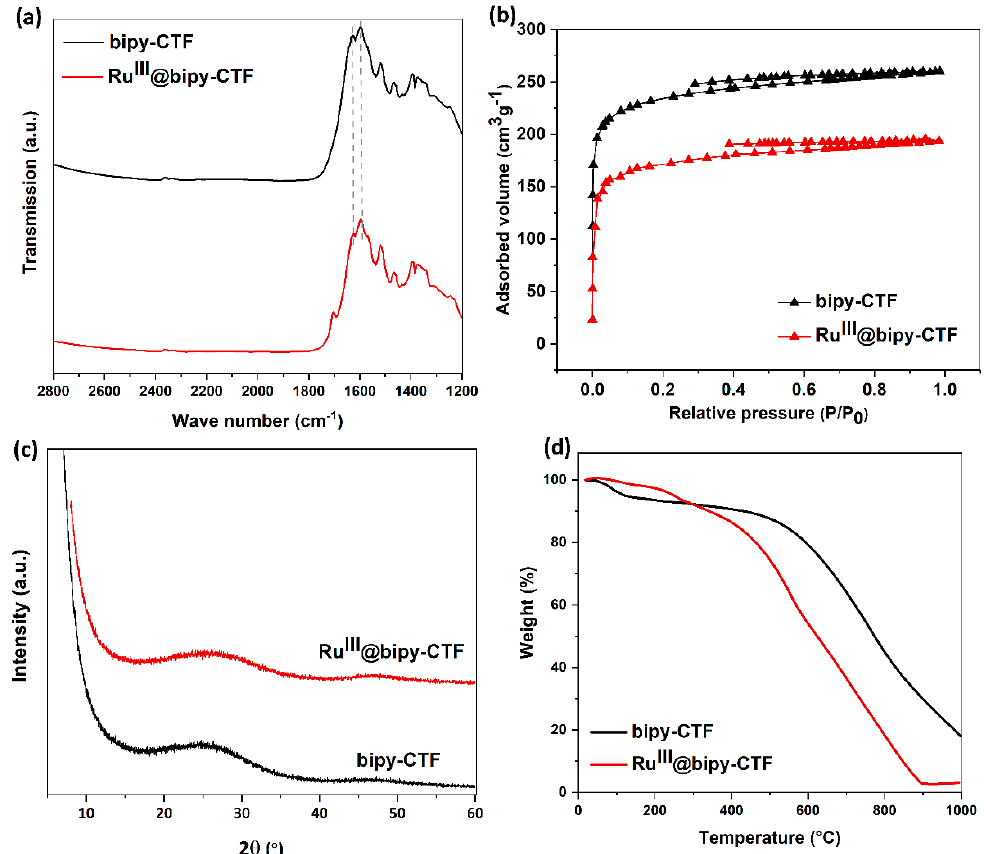
Figure 2. Structural characterization of bipy-CTF and Ru III @bipy-CTF materials. ( a ) Diffuse reflectance infrared Fourier transform (DRIFT) spectra. ( b ) Nitrogen adsorption/desorption isotherms. ( c ) Powder X-ray diffraction (XRD) patterns. ( d ) Thermogravimetric analysis (TGA) curves.